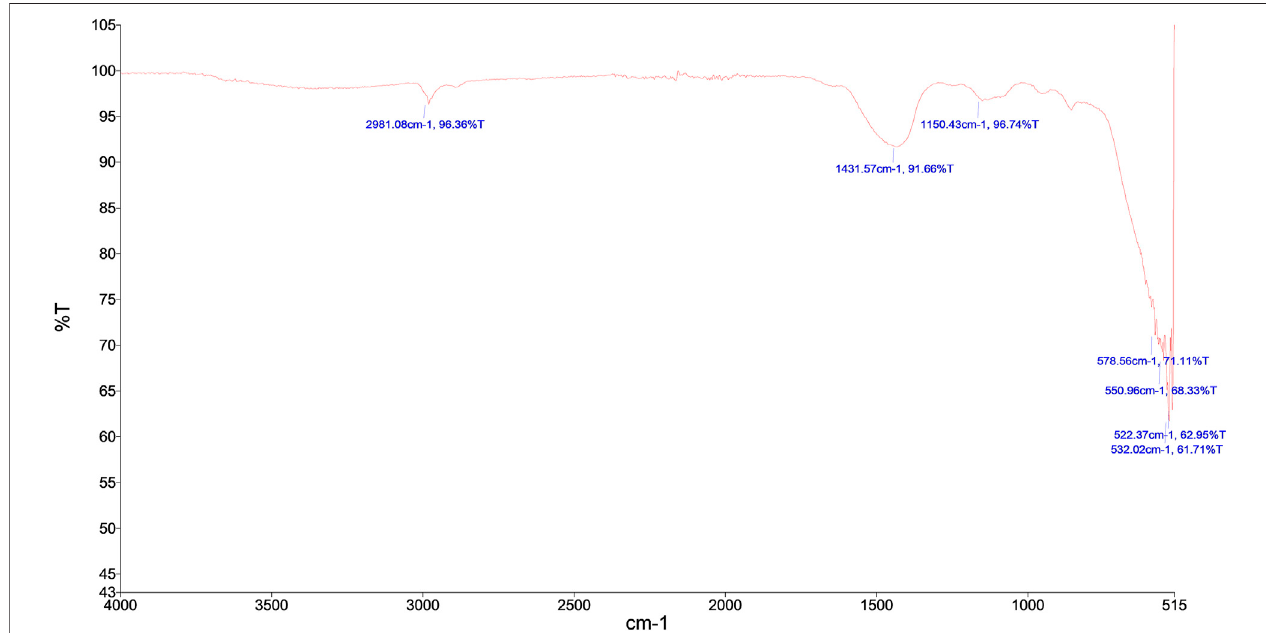
FIGURE 3 | FTIR spectra of MgO